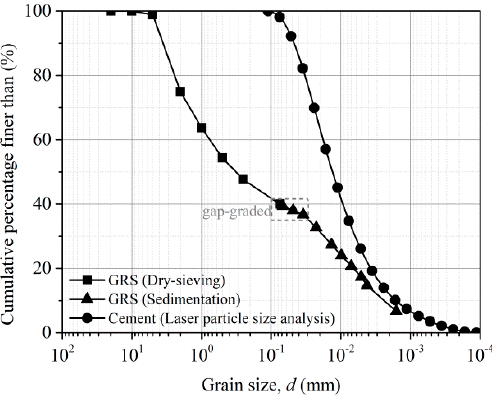
Figure 1. Grain-size distribution curves of GRS and Portland fly-ash cement.